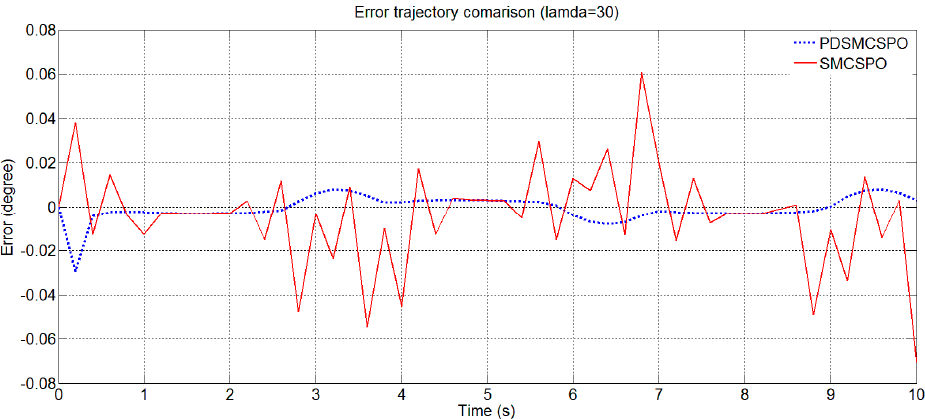
Figure 14. Error trajectory comparisons of both schemes.